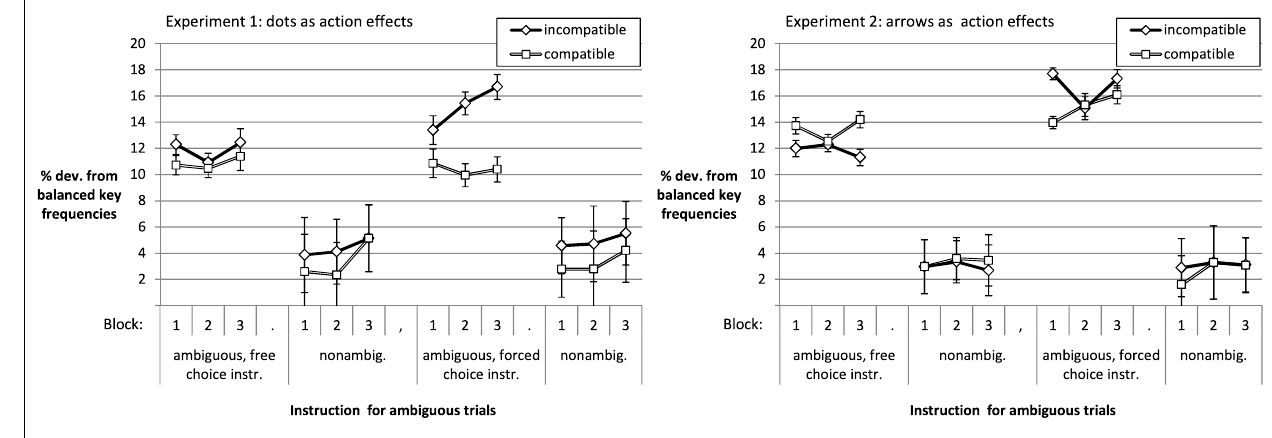
FIGURE 3 | Deviation from balanced response frequencies.